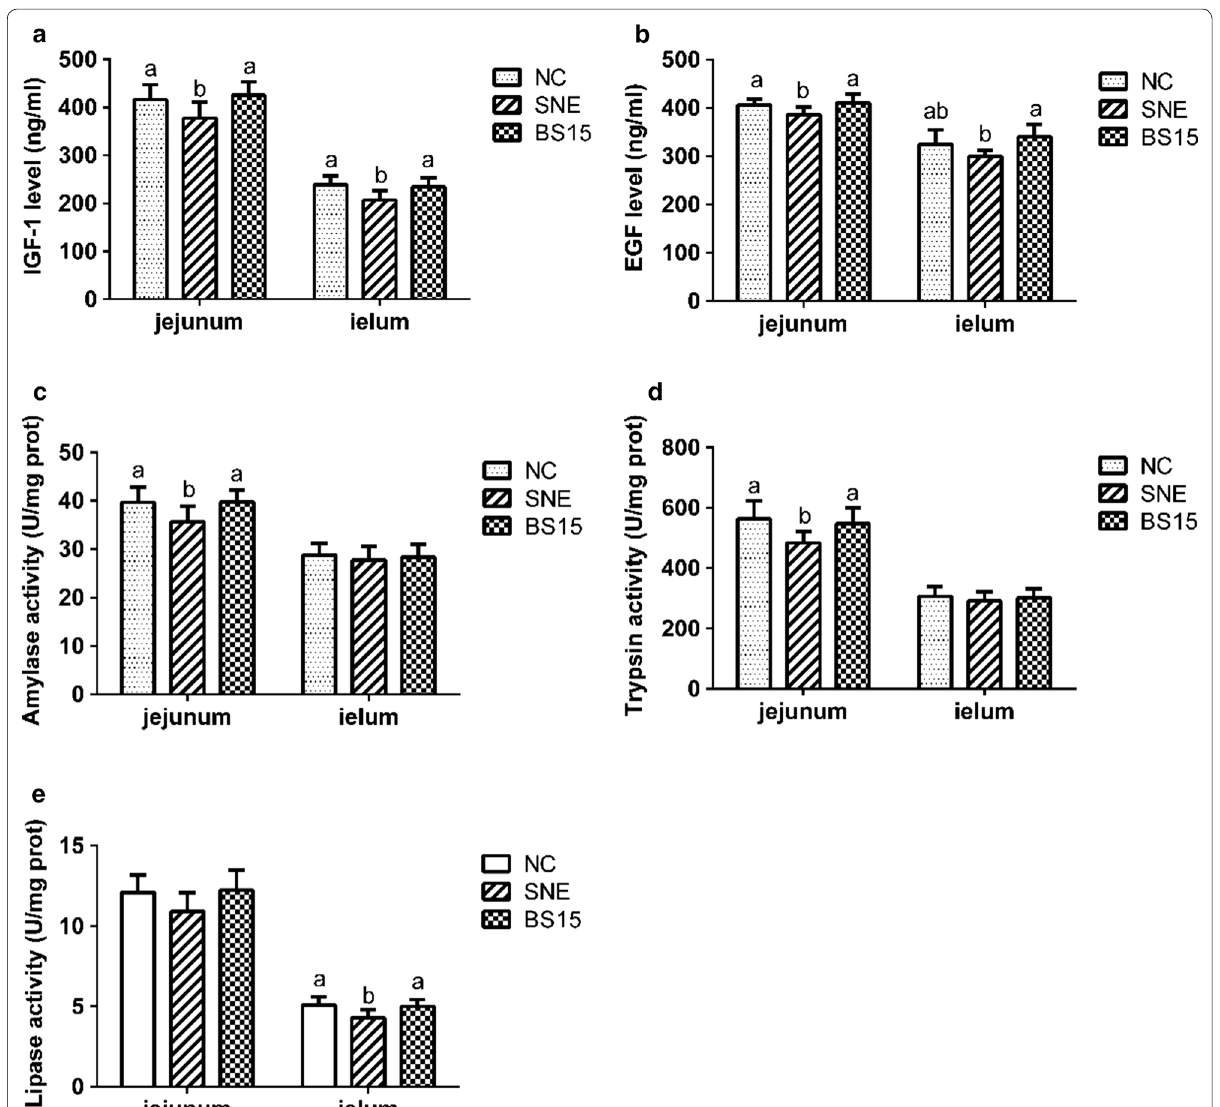
Fig. 1 Effects of Lactobacillus johnsonii BS15 on the development and digestion of intestine. Means in the same row with no superscripts or with a common superscript letter do not differ significantly (P < 0.05). Data are presented with the mean chick per cage). a , b The IGF-1 and EGF levels in jejunum and ileum. c – e The activities of amylase, trypsin and lipase in jejunum and